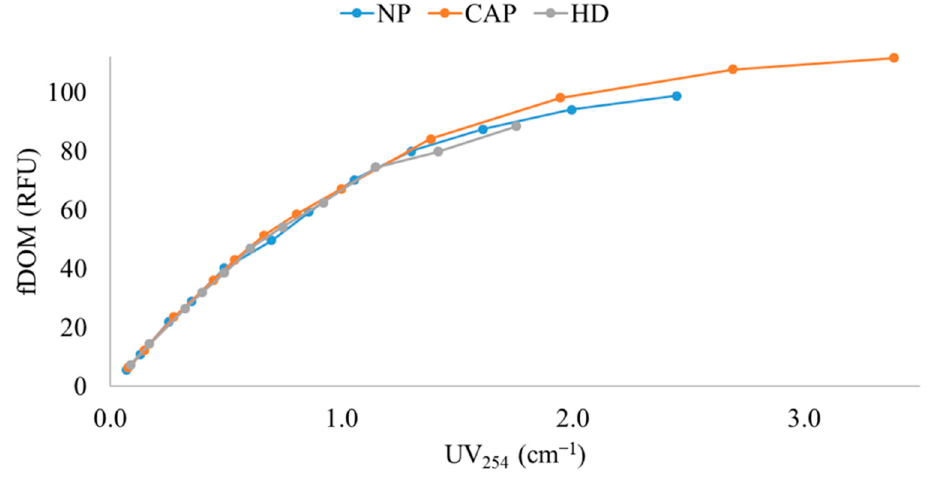
Figure 6. Effects of UV absorbance on fDOM readings; Capalaba, North Pine and Hinze dam.